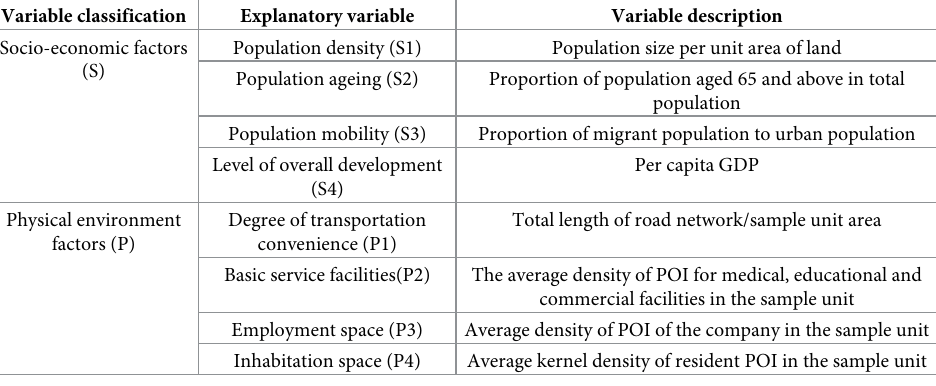
Table 1. The characteristic variables that influence spatial differentiation of Christian